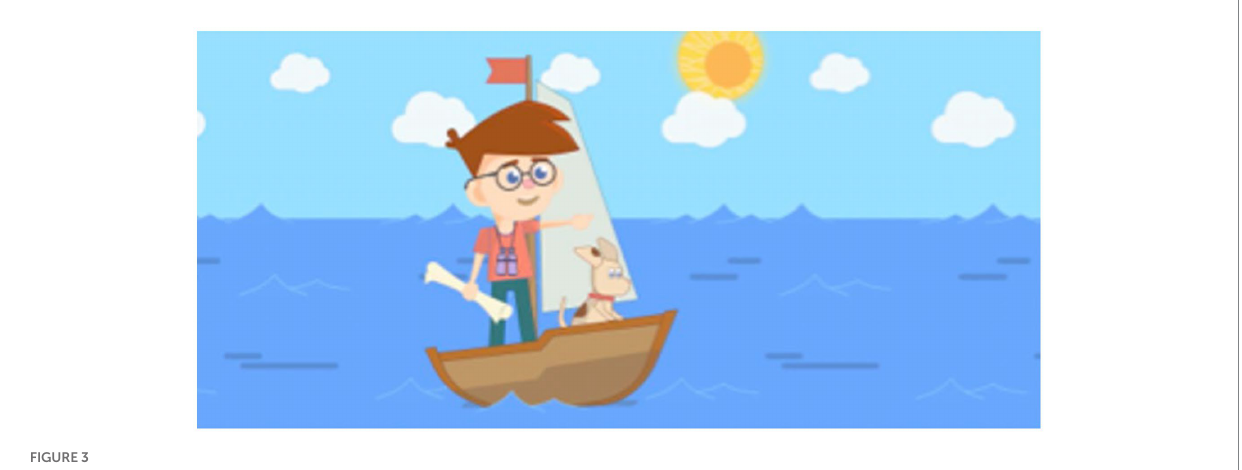
FIGURE 3 Screen from the language explorer story in the